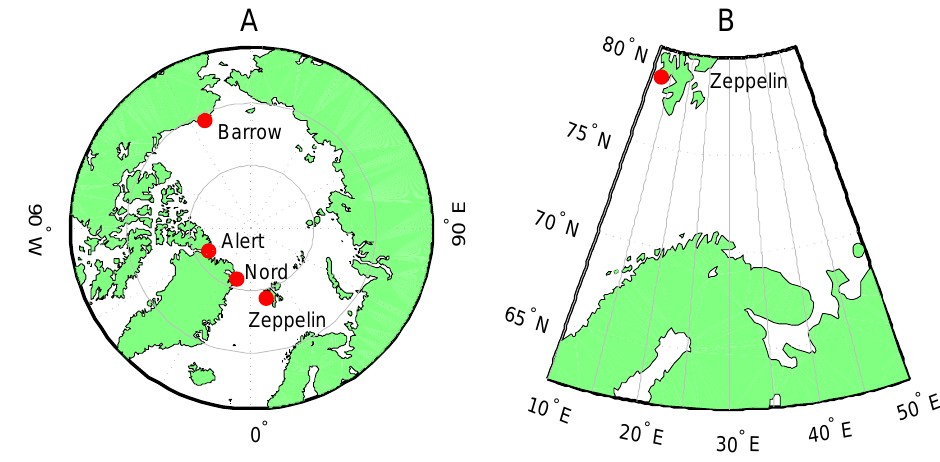
Fig. 1. (A) Map indicating the location of Polar study sites for atmospheric GEM, RGM and PHg measurements. (B) Map indicating the location of Zeppelin in Ny- ˚Alesund, on the Vest coast of